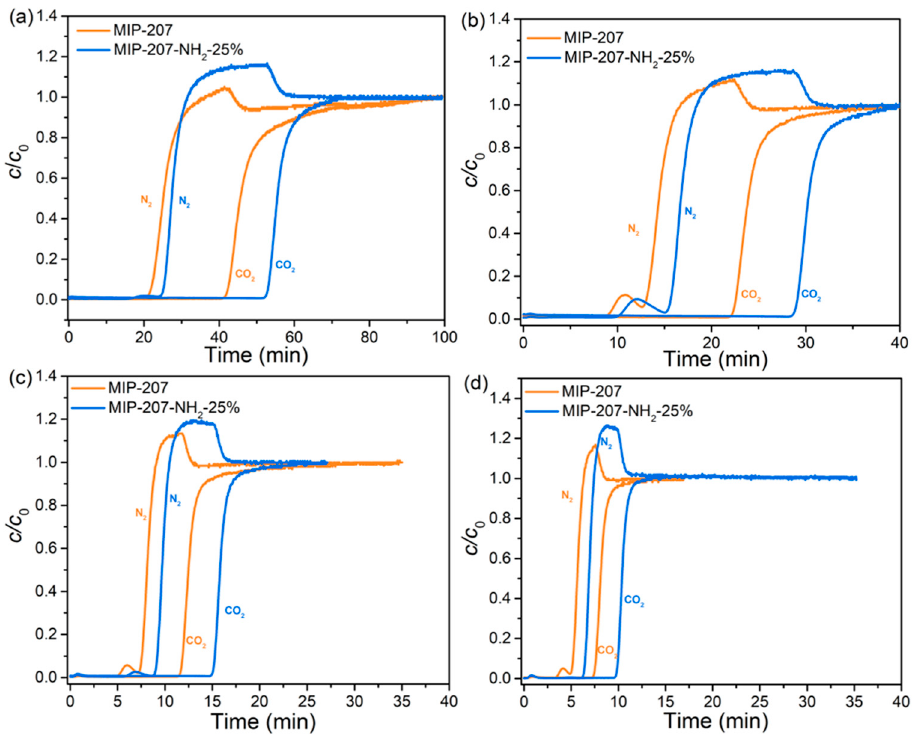
Figure 7. CO 2 and N 2 breakthrough curves of MIP-207 and MIP-207-NH 2 -25% at different gas flow rates: ( a ) 10 sccm, ( b ) 20 sccm, ( c ) 50 sccm, and ( d ) 100 sccm, respectively.